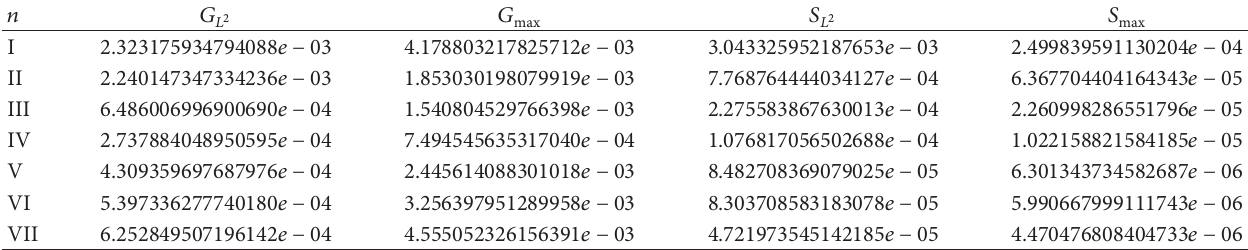
Table 5: Error values of (46) in Example 3.